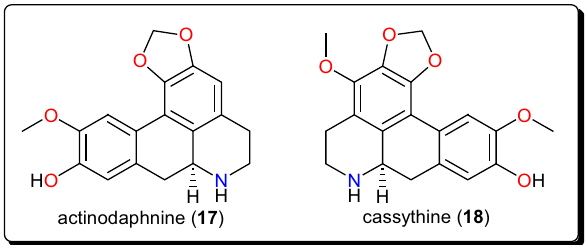
Fig. 3 Aporphine alkaloids with trypanosidal